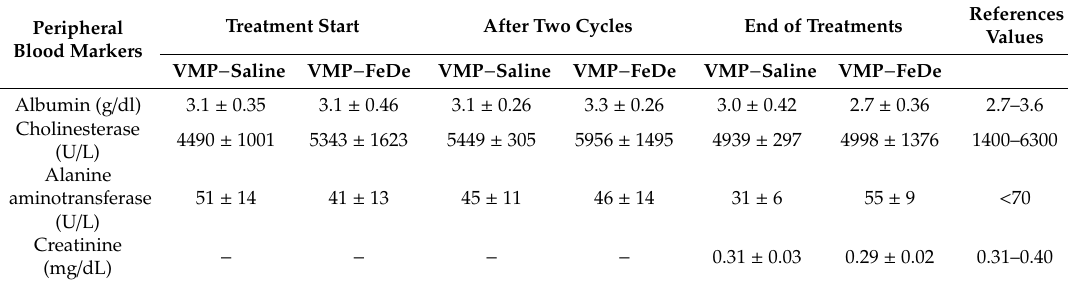
Table 1. Serum indicators of liver and kidney damage and functionality.